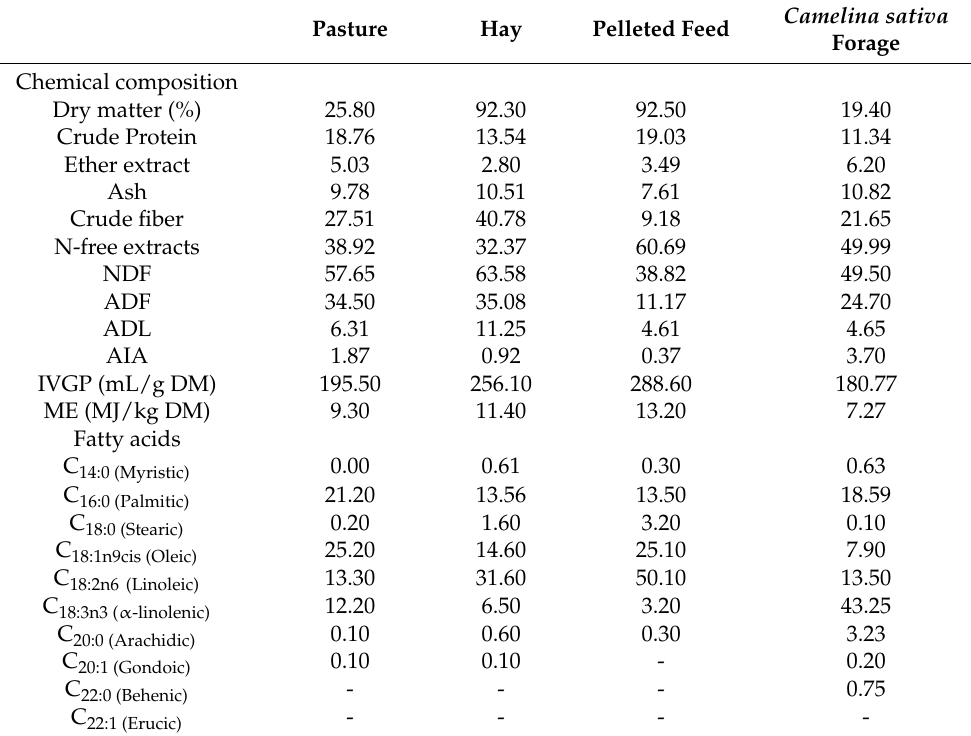
Camelina sativa Forage